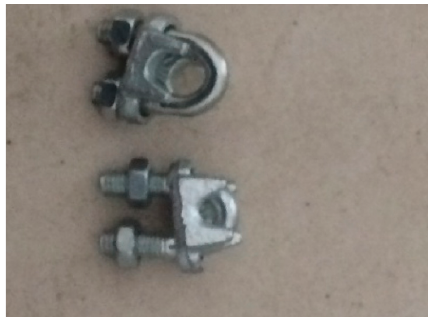
Figure 5: Physical components used for the conductor line sus- pension clamp model.